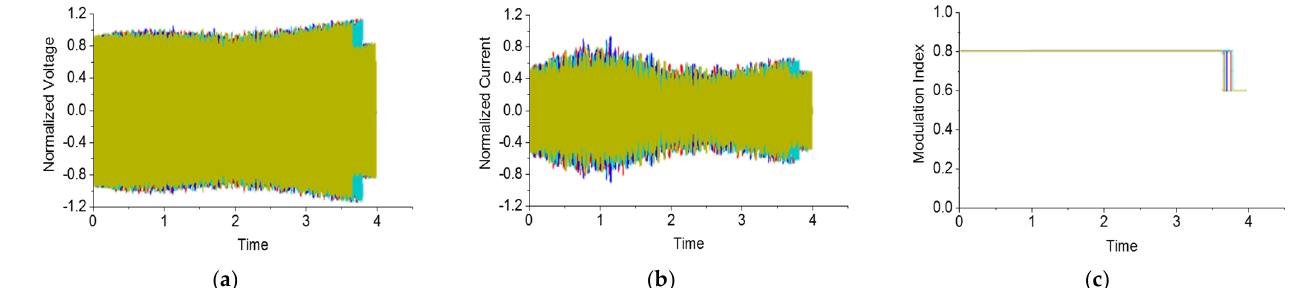
Figure 13. The output voltage and current with the IVCC in the MCAT load: ( a ) the normalized output voltage; ( b ) the normalized output current; ( c ) the modulation index.